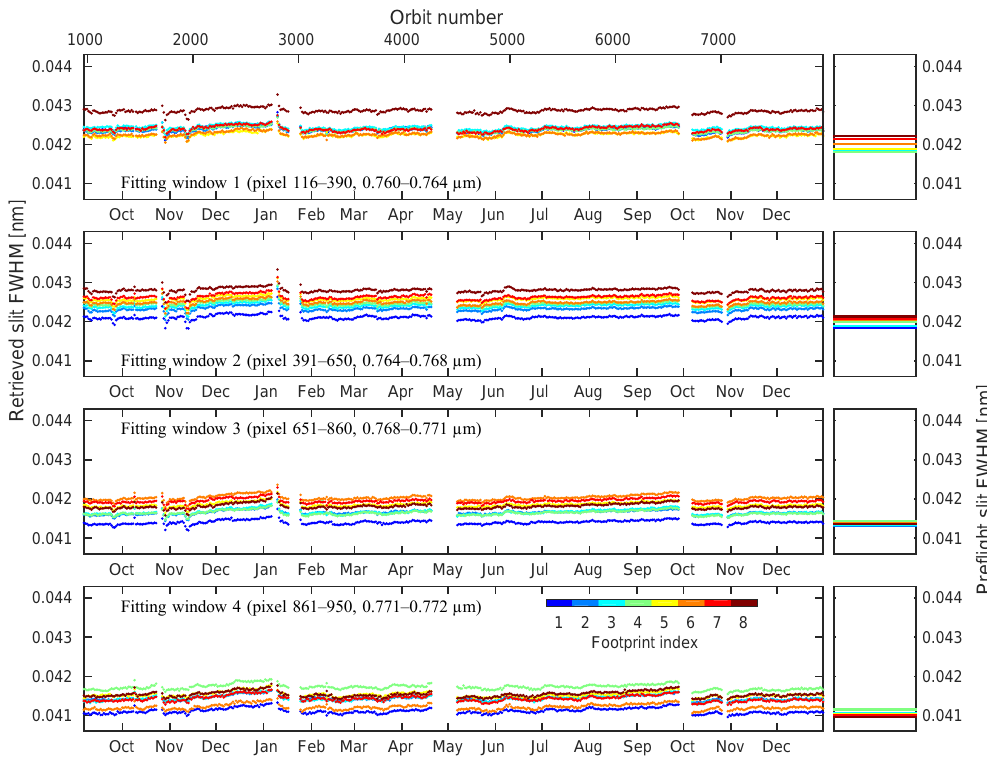
Figure 8. Similar to Fig. 7, but the ILS was fitted by stretching the preflight ILS.